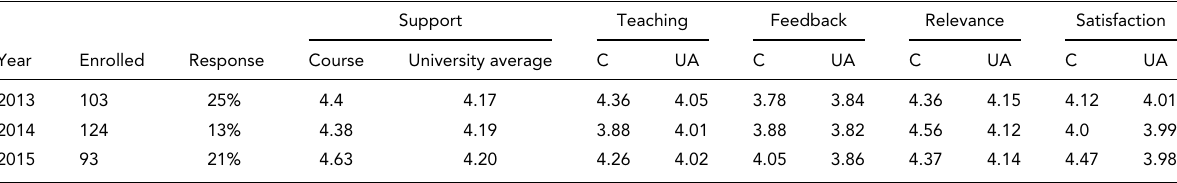
Summary of Online Student Feedback on Course Results 2013–2015 Compared to the University